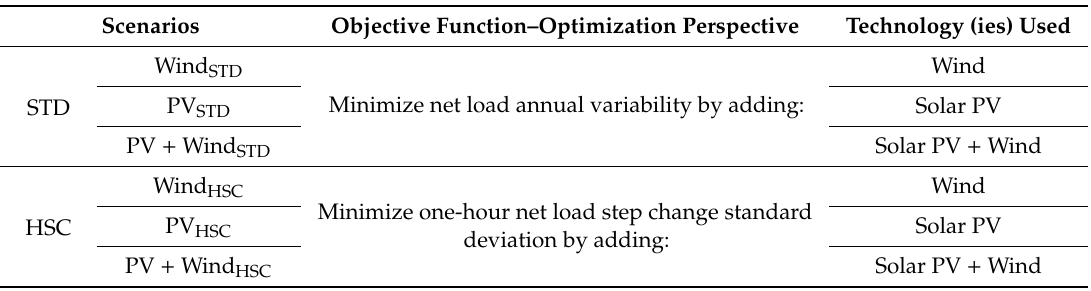
Table 1. Scenarios and optimization perspectives